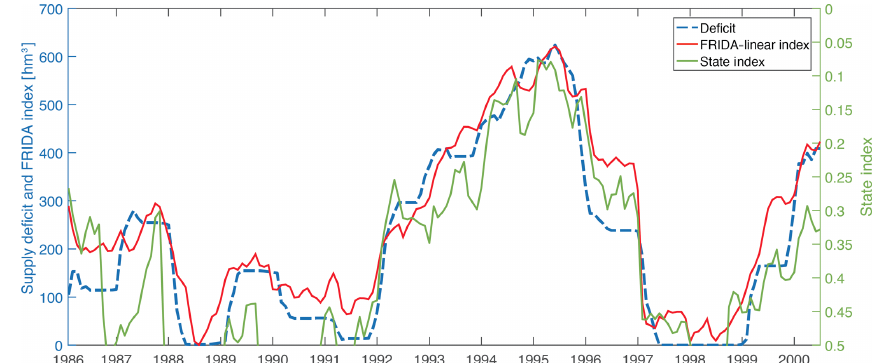
Figure 6. Comparison between the FRIDA-linear index (red plot, blue scale on the left) and the state index (green plot, green scale on the right) in reproducing the monthly aggregated supply deficit (blue dashed plot, blue scale on the left). The FRIDA index presents a higher similarity with the deficit and only requires 5 inputs instead of the 12 required by the state